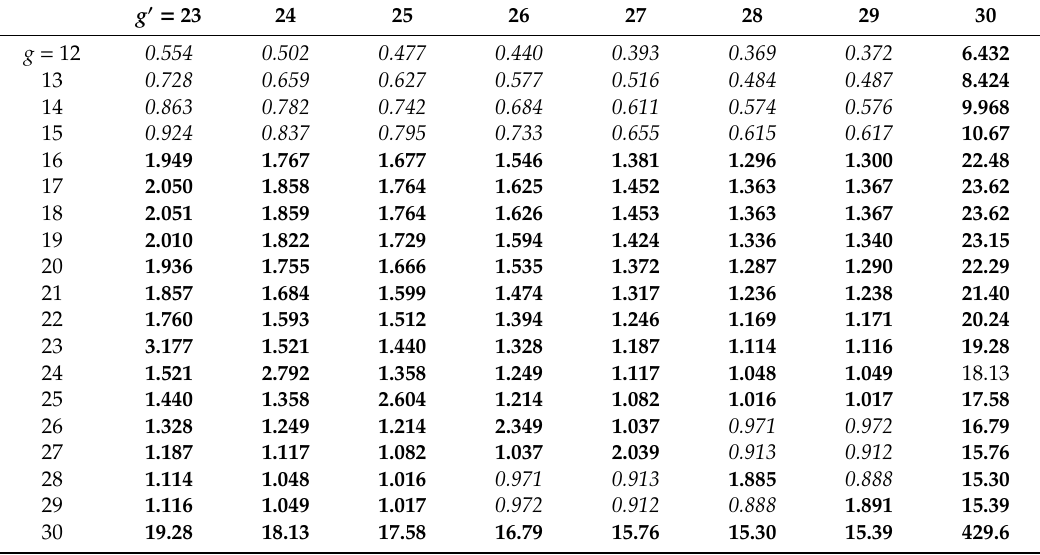
Table 17. Continuation of Table